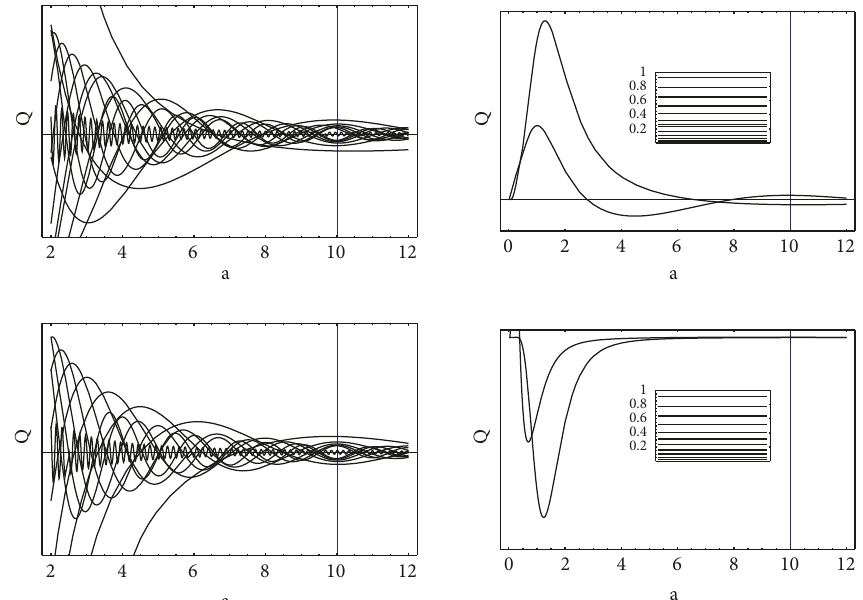
Figure 8: Eigenvalues ( 0 < 𝐸 < 1 ) and eigenfunctions for the linearized dipole equation for 𝜒 = 0.5 and 𝐿 = 0 (upper frames) and 𝐿 = 3 (lower frames) with boundary condition at 𝑎 ∞ = 10 . In the left frames we zoom in all the eigenfunctions for a given 𝐿 around the exterior boundary. In the right frames, we plot the wave functions for the first two lowest energy values. The little windows inside the right frames show the whole spectrum of energies for these 𝑎 ∞ ,𝜒, 𝐿 values.